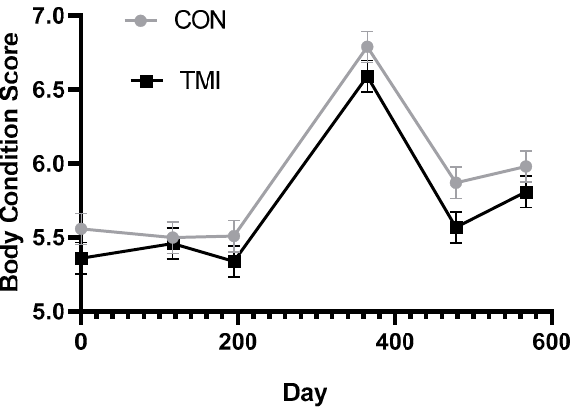
Figure 3. Comparison of trace mineral injection (TMI) or no trace mineral injection (CON) on body condition score (1—emaciated, 9—obese) of cows. Injections were given pre-calving (days 0 and 365) and pre-breeding (days 117 and 478). Day 0 score used as covariate ( p < 0.01). Treatment by day ( p = 0.81), treatment ( p = 0.01), day ( p < 0.01).